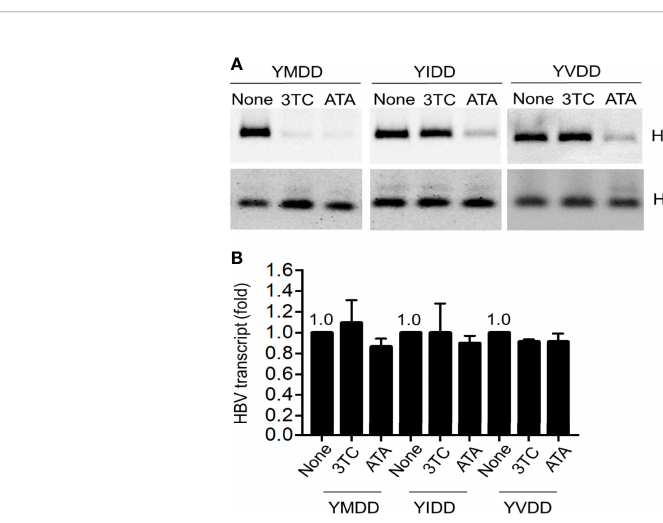
FIGURE 4 | ATA inhibits lamivudine-resistant mutant HBV replication. Huh-7 cells were transfected with HBV replicon plasmids, as indicated. At 24 h after transfection, cells were treated with or without 3TC or ATA for 48 h, and HBV nucleocapsids in cell lysates were estimated (A) using the NAGE assay followed by Southern or Western blotting with HBV DNA probes or anti-HBc antibody (NAGE assay). (B) Total RNA was extracted in panel (A) , and HBV transcripts were measured by RT-qPCR normalized by GAPDH. Data are mean ± SEM of three independent experiments. All Western blotting data are representative of three independent experiments. ATA, aurintricarboxylic acid; HBV, hepatitis B virus; NAGE, native agarose gel